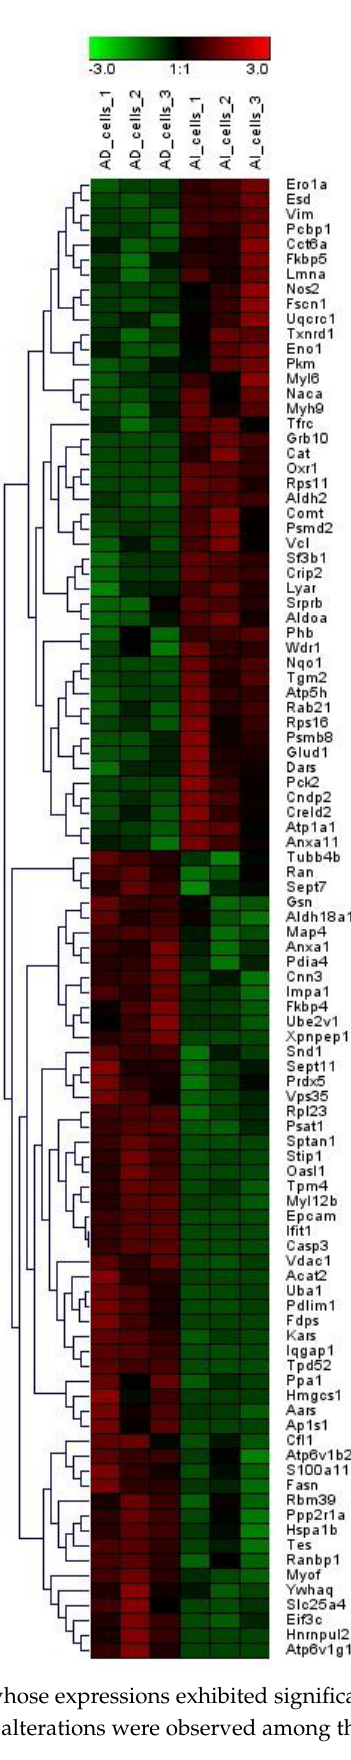
Figure 1. Heatmap of proteins whose expressions exhibited significant differences between PLum-AI and PLum-AD cells. Expression alterations were observed among these proteins.